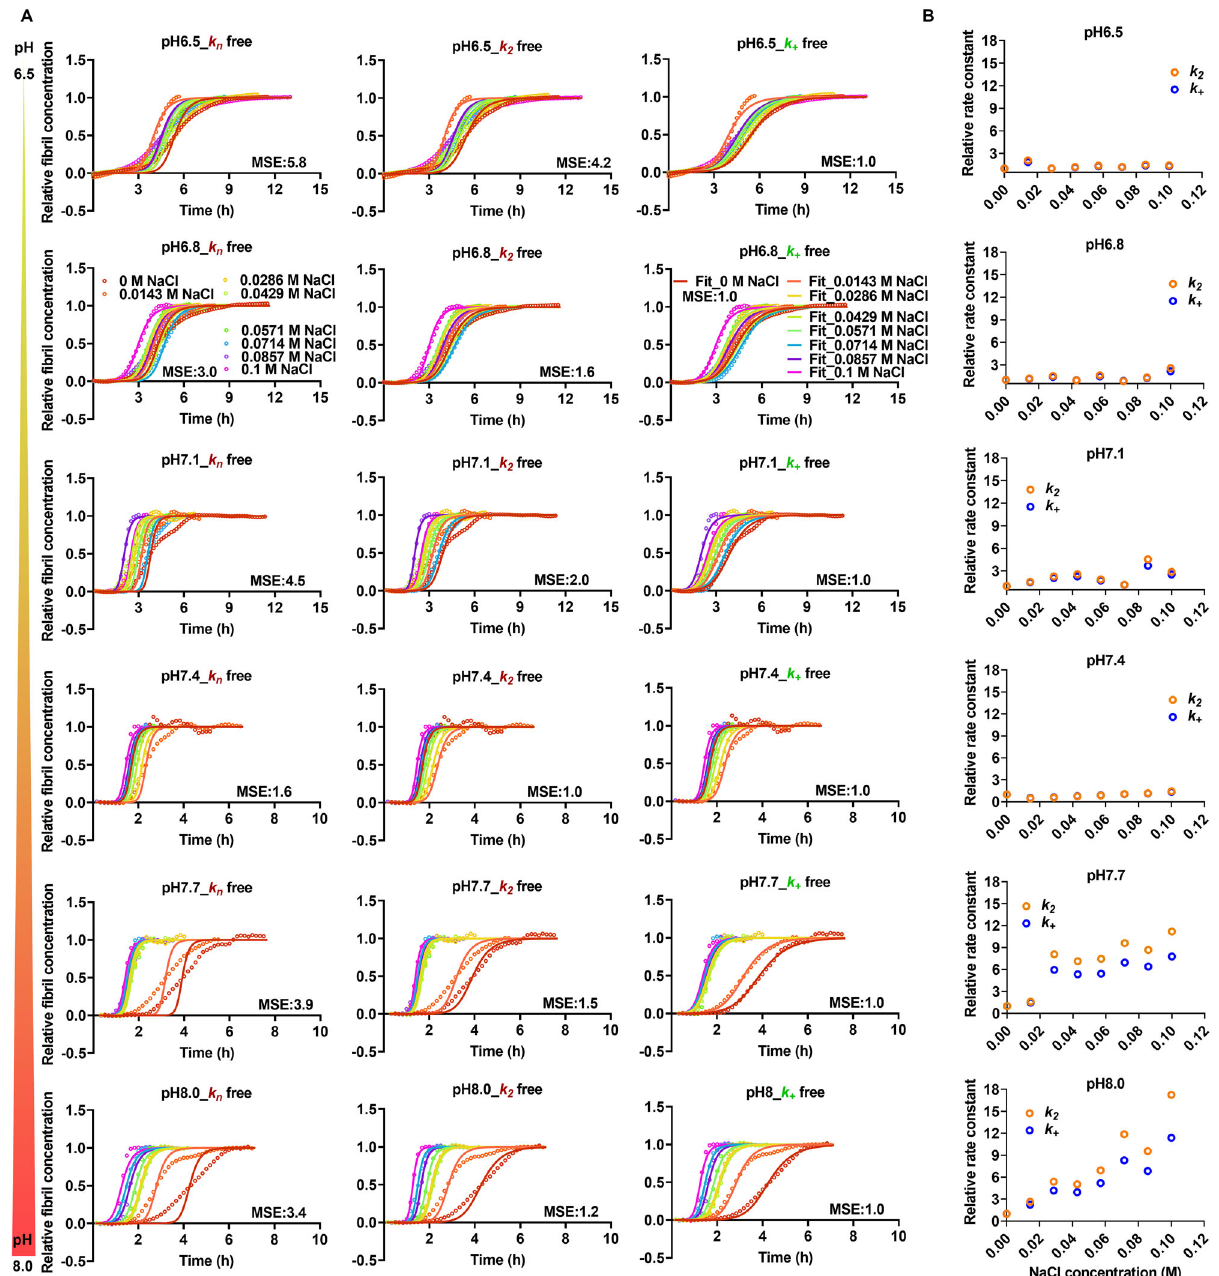
Fig. 5 Different pH values and NaCl concentration mainly in fl uence the secondary processes of the kinetics of A β 40 fi brillation in the absence of Zn 2 + ions. A Aggregation kinetics of10 µ M A β 40 atdifferent pH values(6.5, 6.8,7.1, 7.4,7.7, and 8)and concentrationsofNaCl (0, 0,0143, 0.0285, 0.0429, 0.0571, 0.0714, 0.0857, and 0.1 M) were monitored by ThT fl uorescence over time. The ThT data were then globally fi tted by using the AmyloFit online software server 38 . For the fi tting procedure, the data of A β 40 at pH 7.4 in the absence of NaCl were fi rst fi tted with a secondary nucleation dominated model, from which = 0.00047 in the unit of concentration − nc + 1 time − 1 , k = 4× 10 7 in concentration − n2 time − 1 , and k = 9.49×10 8 in a set of parameters including k þ n 2 concentration − 1 time − 1 of A β 40 fi brillation were obtained and used as the initial guess values for the following global fi t. Each one of the rate constants k n , k 2 , or , but not k þ was fi tted freely, while the other two were set as initial guess values, by choosing the secondary nucleation dominated model. When k þ and/or k 2 k n , were freely fi tted then the data was well described (see main text for details). The mean square error (MSE) values for each set of A β 40 samples were normalized against the one with the best fi t (lowest MSE value). B Relative rate constants (relative to the rate constants of A β 40 at pH 6.5) derived from global fi tting for A β 40 samples at different pH values and salt